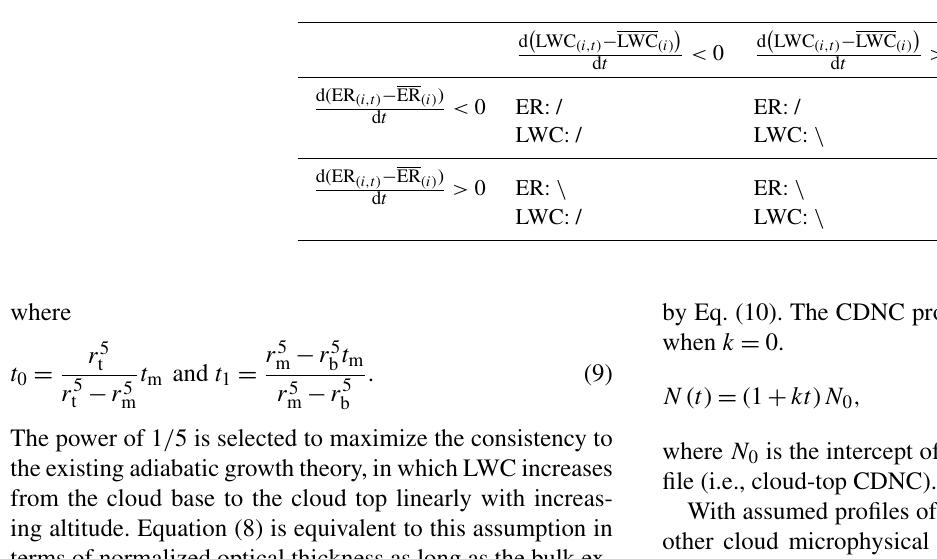
Figure 8. (a) The percent of profiles for weak precipitation (WP); the bins are characterized by quartile boundaries. (b) Same as (a) but for strong precipitation (SP). (c) The percent of profiles for weak precipitation (WP); the bins are characterized by arithmetic mean boundaries. (d) Same as (c) but for strong precipitation (SP). The boxes that received more than 10% of the examples are underlined by a dotted blue line for WE cases and by a dotted tangerine one for SE cases. Panels (e) and (f) show the difference between the percent of samples for LWC and ER between SP (b) and WP (a) cases; (g) and (h) show the difference between the percent of samples for LWC and ER between SP (d) and WP (c) cases. In (e) – (h) , red color and blue color indicate the increase and decrease in the samples; small variations in percent (within ± 3%) are plotted with a dotted line. Table 1. The criteria to classify four LWC and ER patterns according to the slope of above-turning-point